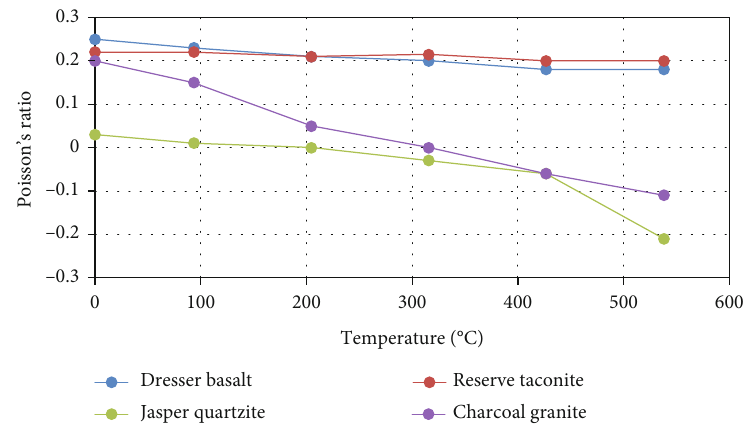
Figure 6: Poisson ’ s ratio of di ff erent rocks at various temperatures.